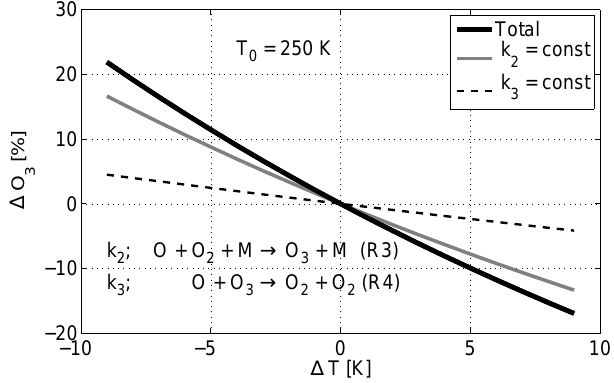
Figure 8. Ozone variations induced by temperature variations in a pure-oxygen atmosphere. “Total” denotes the result obtained for variable, temperature-dependent reaction rate coefficients k 2 (T ) and k 3 (T )